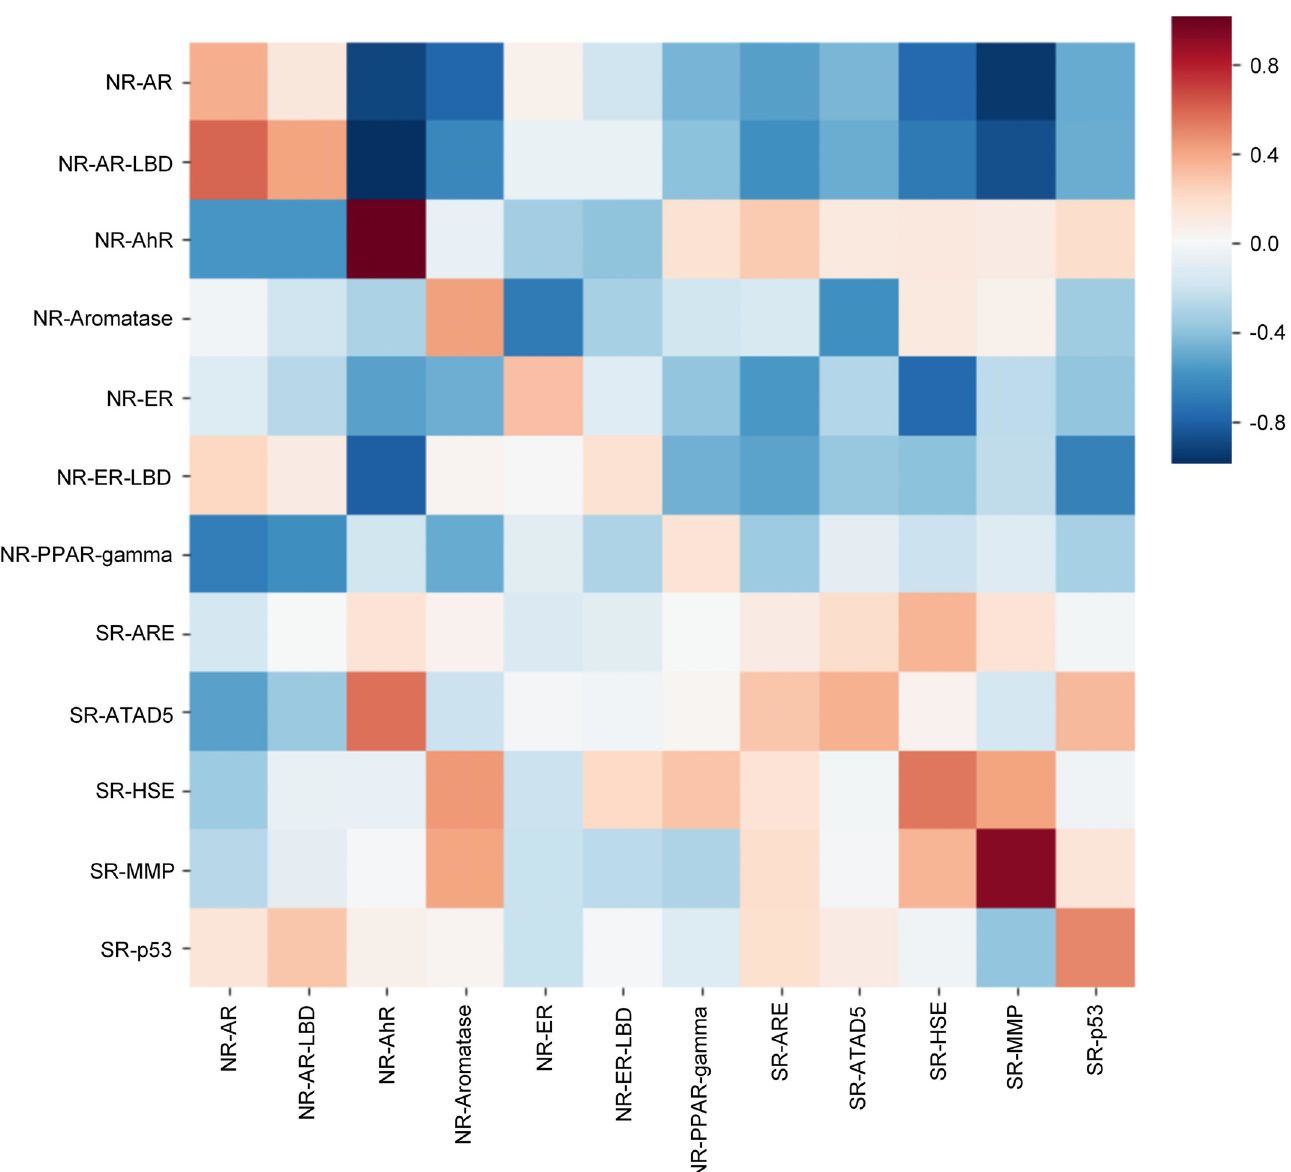
Fig 11. The correlation between predictions and observations of our model on different tasks in tox21 data set (scaffold split).